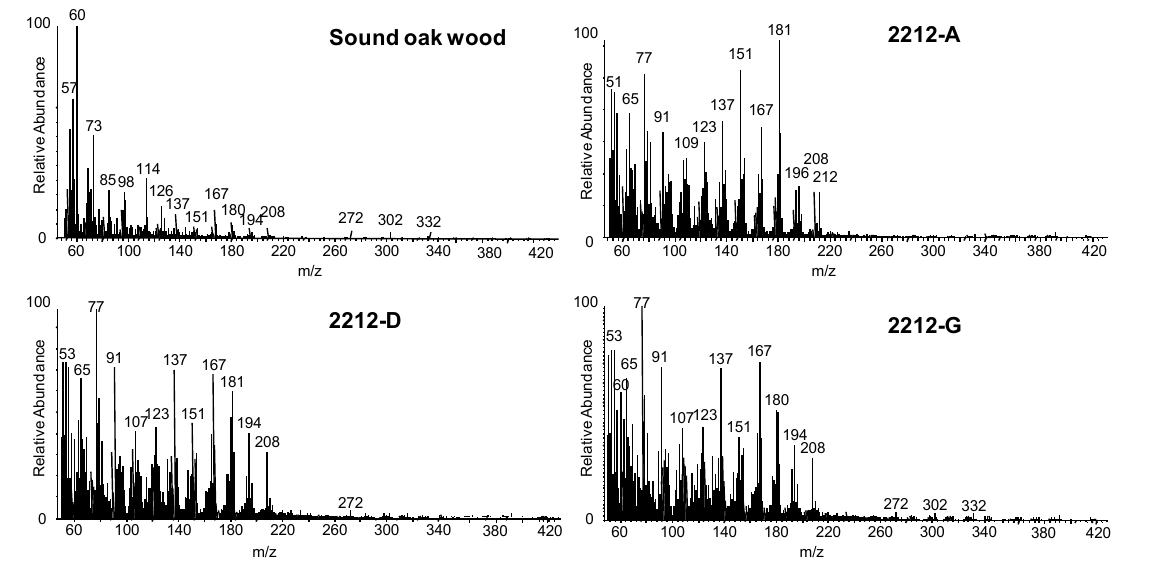
Figure 4. Overall mass spectra obtained by EGA-MS analysis of sound oak wood and archaeological wood samples collected at different depths from the surface, in the surface (A—rings 11–15), in the middle (D—rings 26–30), and in the core (G—rings 46–48) of pile 2212 from La Marmotta. Adopted from [33].